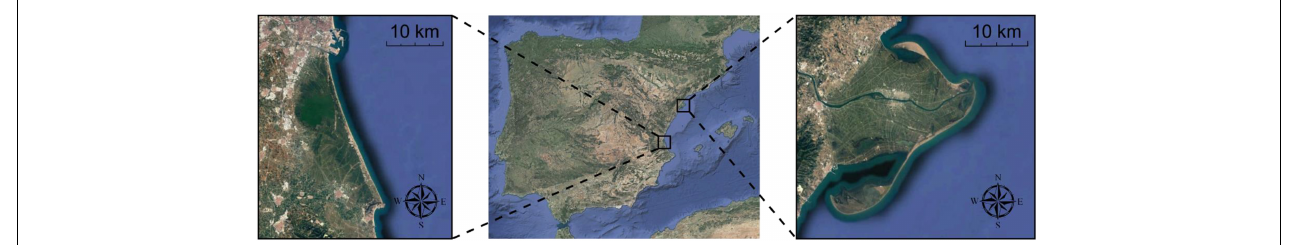
FIGURE 1 | Satellite image of Spain (center), l’Albufera (left), and Ebro Delta (right). Source: Google